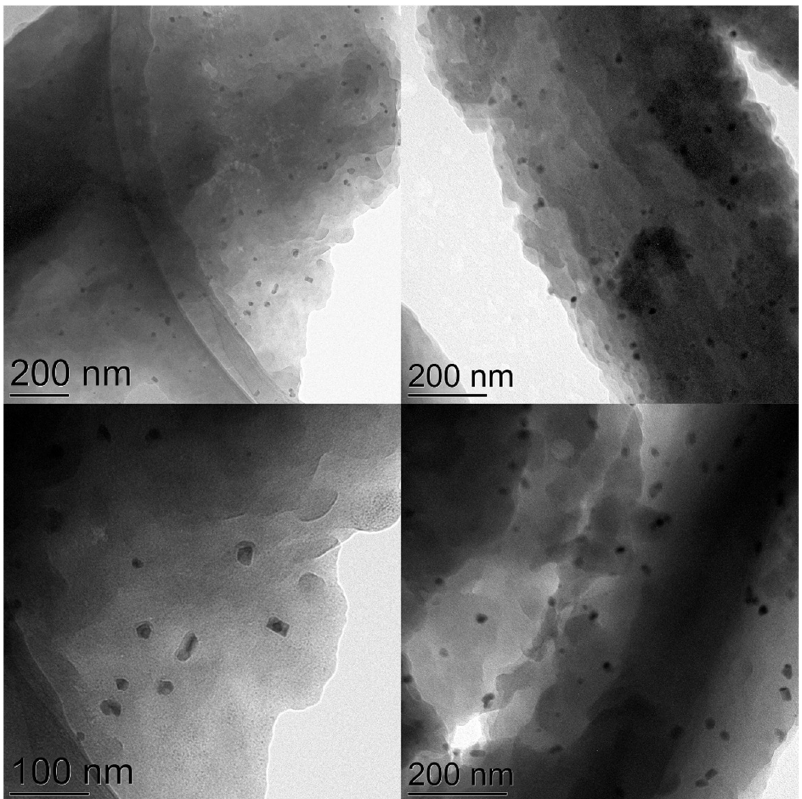
Figure 4. TEM micrographs of a sample of hydrolysis lignin coated with nickel compounds (7% wt.) after calcination in a CO 2 atmosphere.